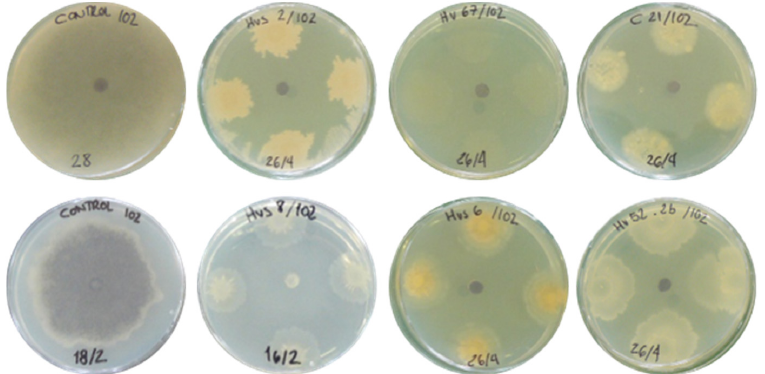
Figure 2. Medium-high and very high inhibition of mycelium growth of Macrophomina phaseolina TOR-102 isolate by several bacterial strains on NB medium by dual-culture assay.